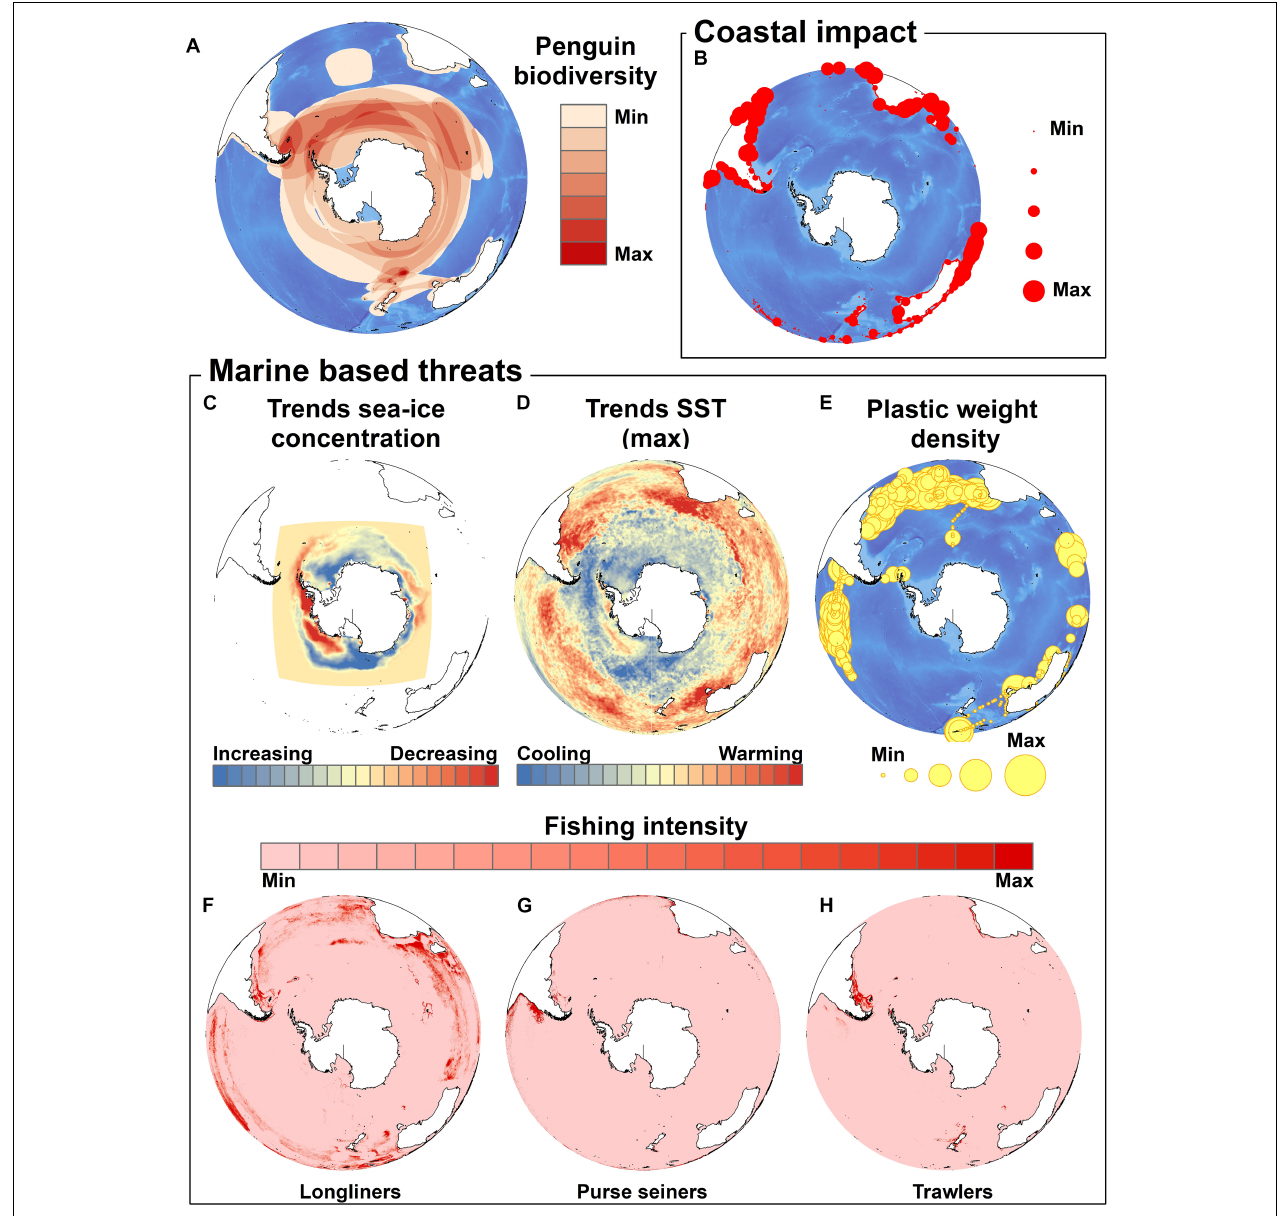
FIGURE 1 | Major coastal and marine-based threats for penguins. The global occurrence of penguins is depicted as the number of penguin species at any particular location (data from Birdlife International) (A) . The sum of coastal human populations within a 10 km, moving window around any coastal cell (B) was used as a proxy for the intensity of coastal impact (see Halpern et al., 2015). The main marine threats we considered are (C) sea ice trends over 38 years (1979–2017) using averaged monthly data for each year (Fetterer et al., 2017), (D) the slopes of least-square linear regressions of maximum annual SST for a given cell represented here as a proxy for the magnitude of SST change over the 1982–2016 time period (“optimum interpolation SST” sourced at http://www.esrl.noaa.gov/psd/), (E) plastic density (both count and weight density) for 1571 locations around the world (from Eriksen et al., 2014), and the spatial distribution of daily fishing effort (the period that a vessel spends at-sea fishing actively) for (F) longliners, (G) purse seiners and (H) trawlers for the 2012–2017 period (Global Fishing Watch, http://globalfishingwatch.org/; see also Kroodsma et al.,